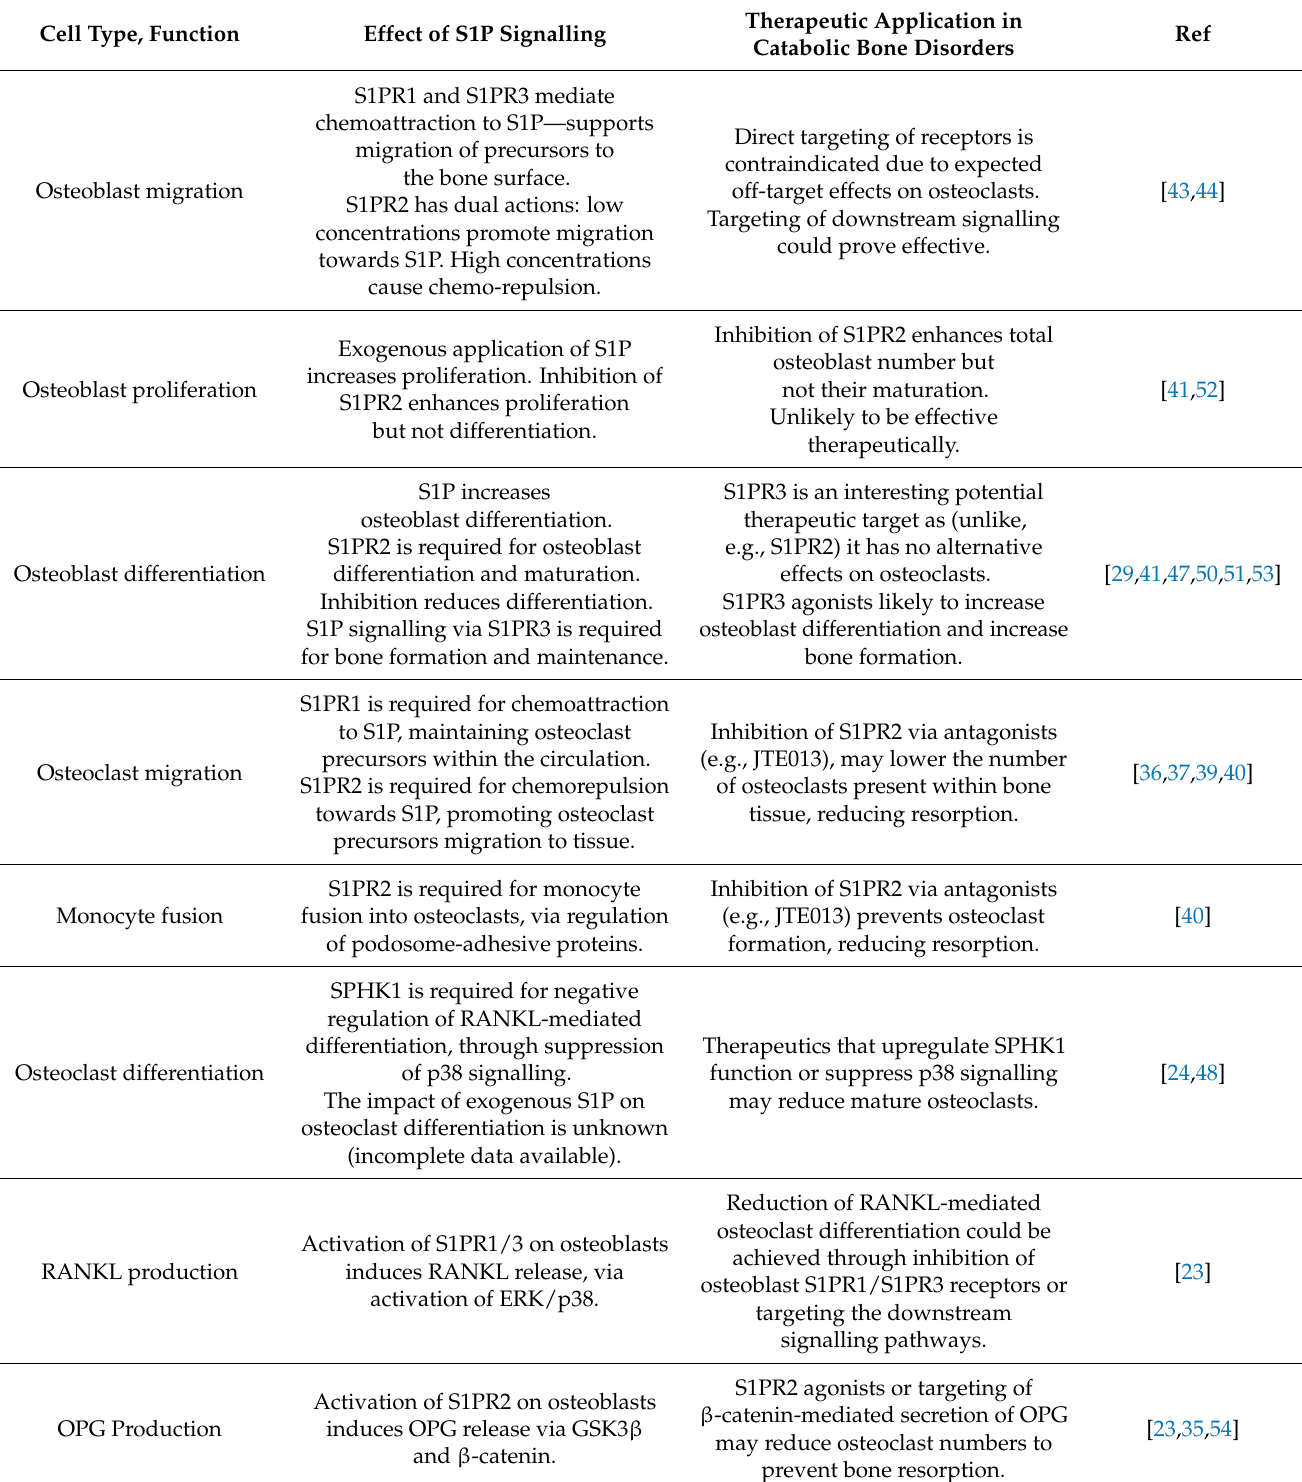
Table 1. Summary table outlining the effects of S1P on the different stages of bone remodelling and their potential as therapeutic targets in catabolic bone